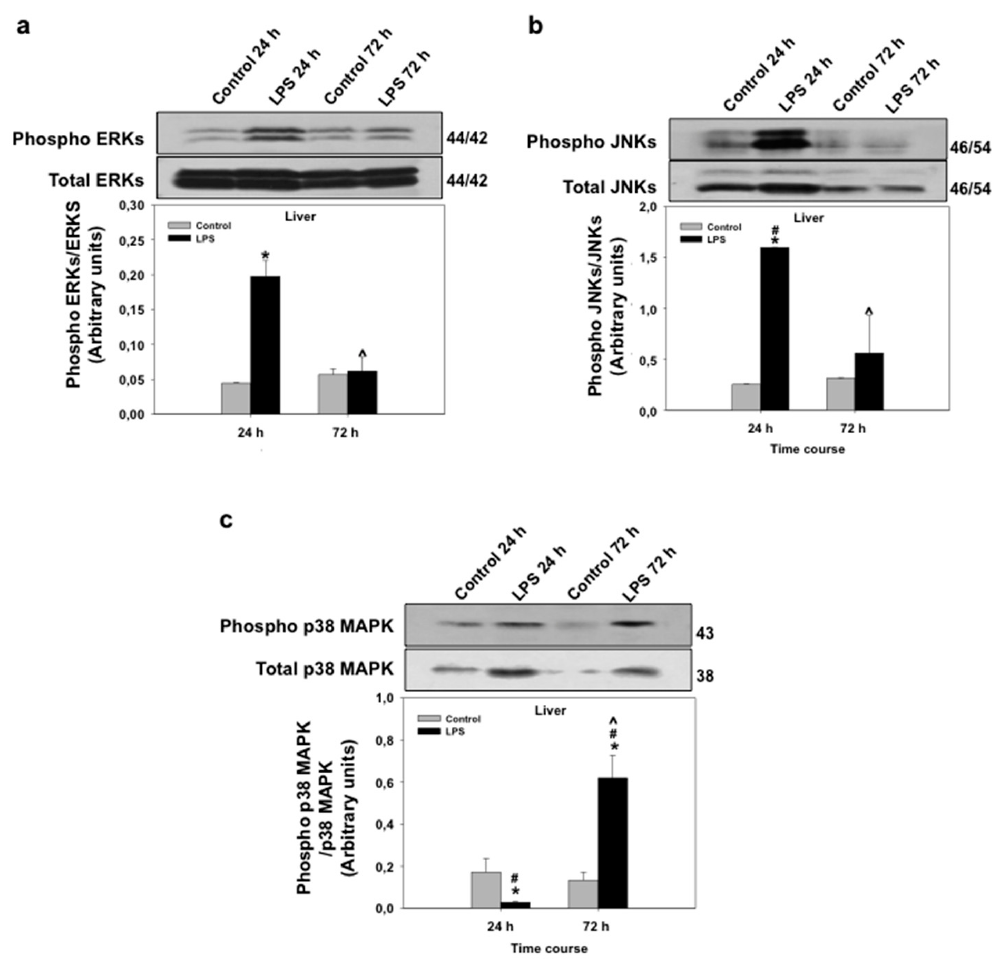
Figure 6. Effects of lipopolysaccharide (LPS) administration in vivo on MAPK phosphorylation levels in the seabream liver. Phosphorylation levels of ERK ( a ), JNK ( b ) and p38 α -MAPK ( c ) were measured by Western blotting in the liver from seabream at 24 and 72 h after LPS administration. Data shown represent the levels of the phosphorylated form (Phospho) (top) relative to the total form (bottom) and are expressed in arbitrary units. The insets show a representative SDS-PAGE with indication of the molecular weights obtained (in kDa). Data shown in bars represent means ± SE of five fish per group. * p < 0.05 compared to the 24 h control group, # p < 0.05 LPS-treated group compared to the respective control group and ^ p < 0.05 compared to the 24-h LPS-treated group.